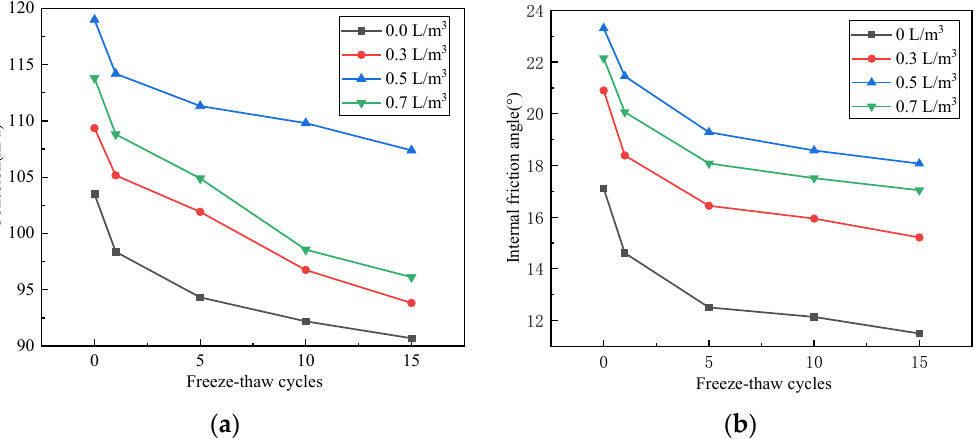
Figure 8. Relationship between shear strength and number of freeze-thaw cycles. ( a ) Cohesion. ( b ) Internal friction angle.